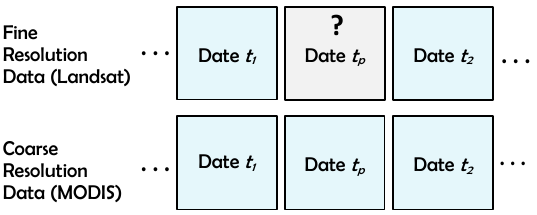
Figure 1. The goal of this data-fusion effort is to estimate a high-resolution Landsat image at time t p from other Landsat images, and from lower-resolution MODIS